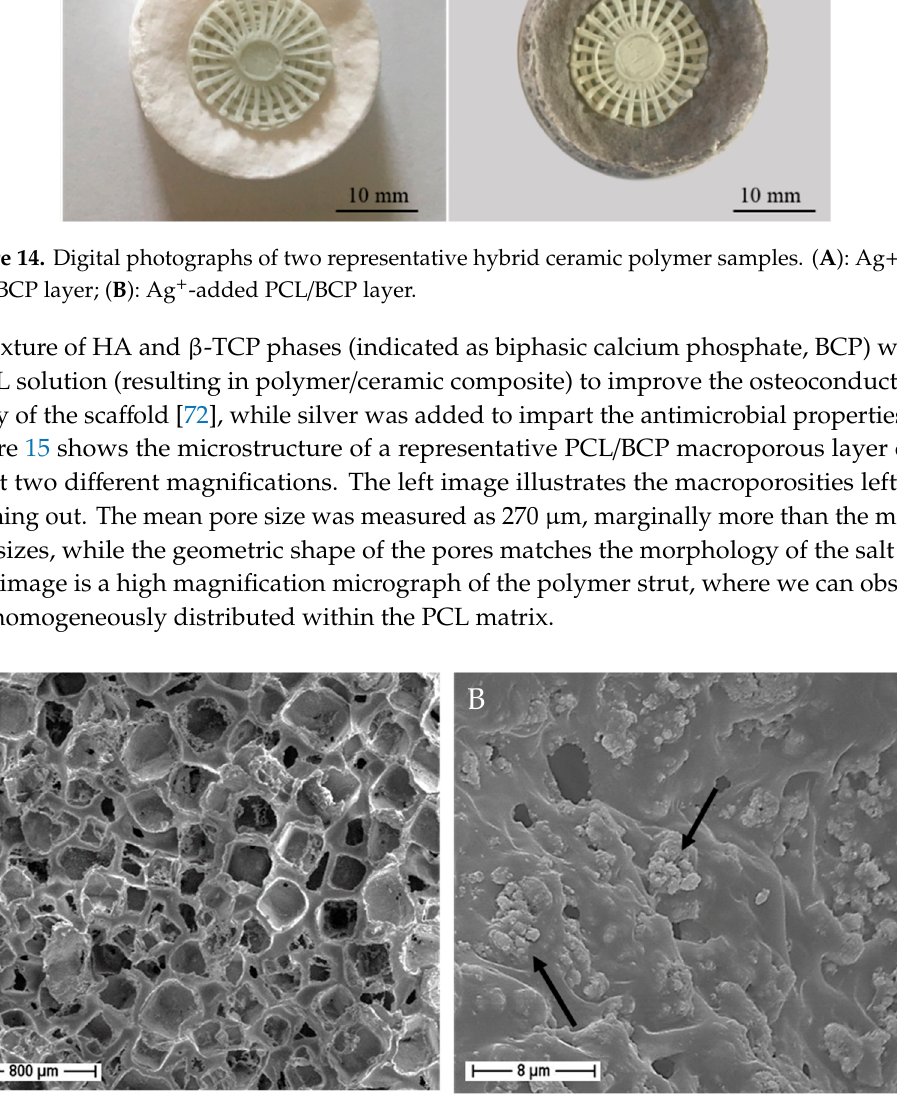
Figure 15. SEM micrographs of the PCL/BCP layer at two different low ( A ) and high ( B ) magnifications.